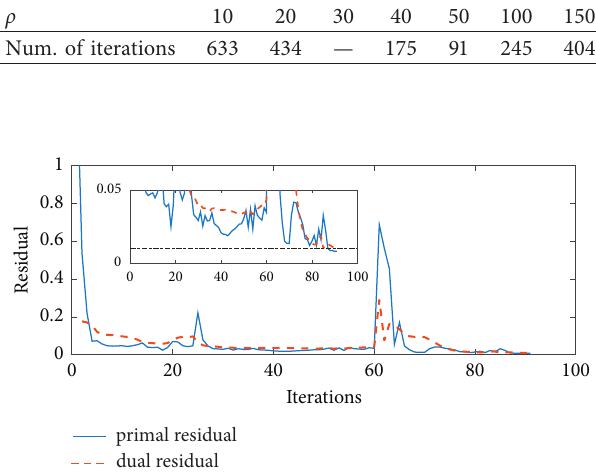
Figure 4: Convergence process of the P-ADMM-based